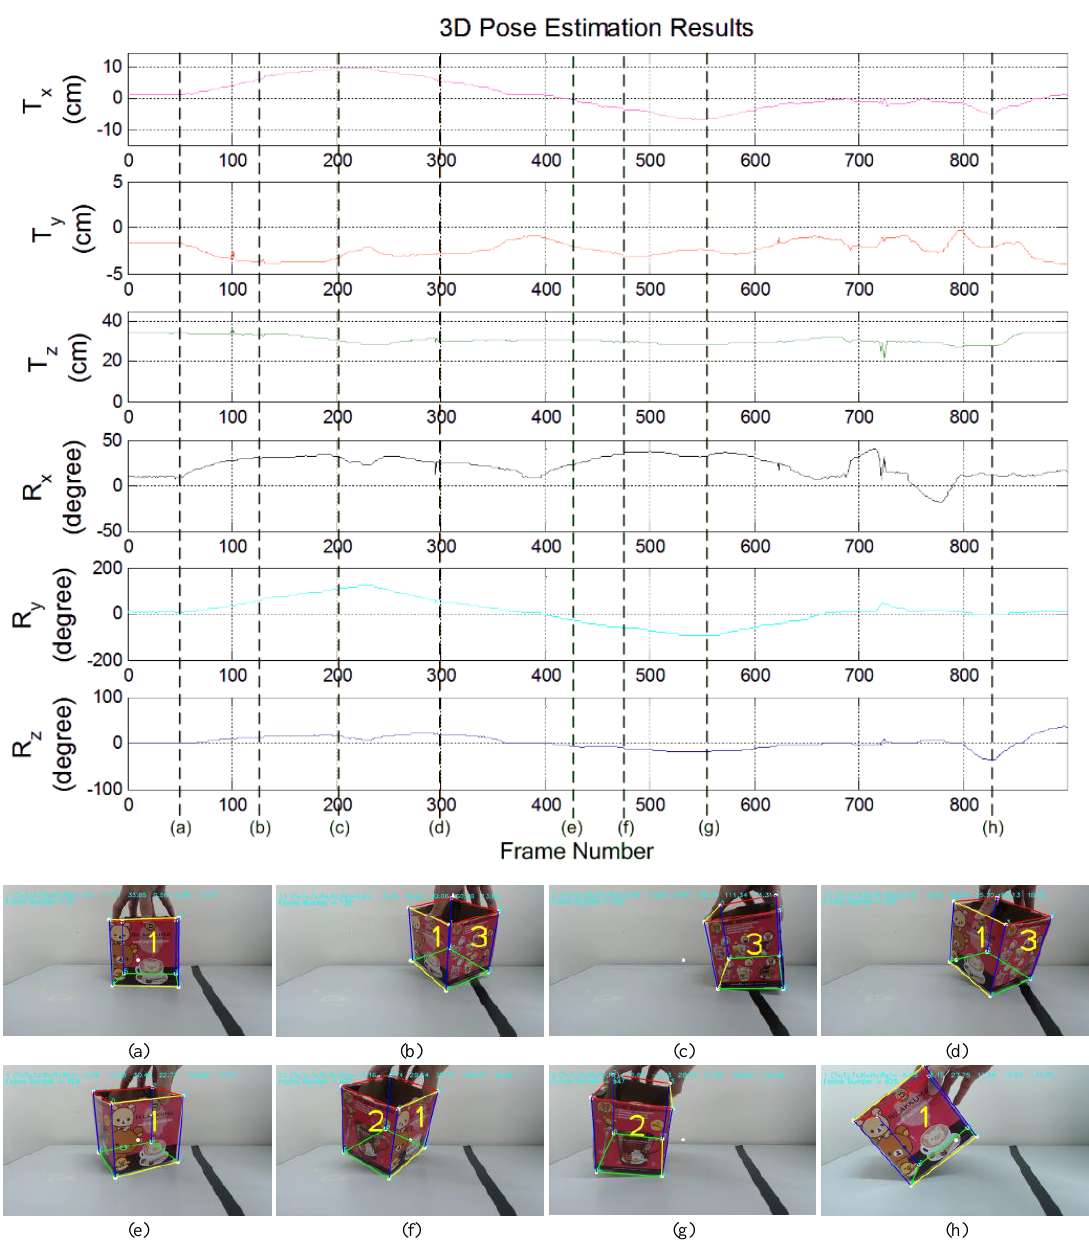
Figure 3. Pose estimation results of the proposed algorithm in tracking the OOI with the three templates shown in Figure 2: 3D pose estimation by tracking ( a ) the template No. 1, ( b ) the two templates No.1 and No. 3, ( c ) the template No. 3, ( d ) the two templates No.1 and No. 3 again, ( e ) the template No. 1, ( f ) the two templates No. 1 and No. 2, ( g ) the template No. 2 and ( h ) the template No. 1 with a rotation on the z -axis.